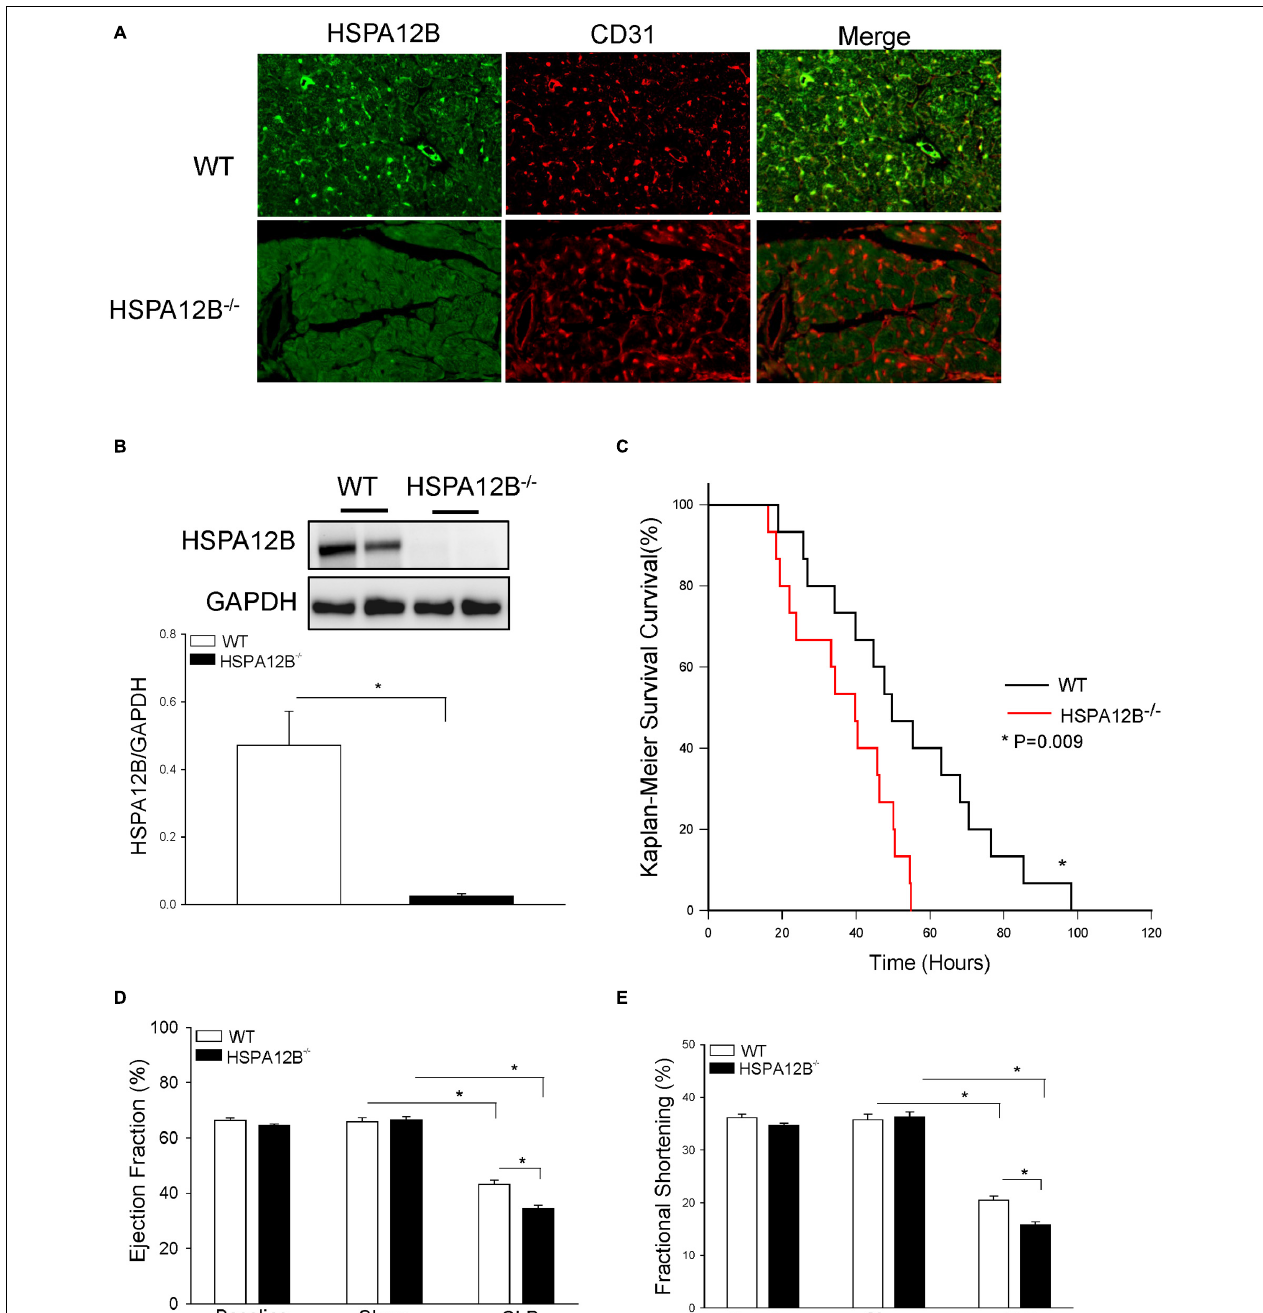
FIGURE 1 | Endothelial-specific deficiency of HSPA12B results in increased mortality and worsened cardiac dysfunction in polymicrobial sepsis. (A,B) HSPA12B is expressed in the ECs of WT myocardium but not in HSPA12B − / − mice. (A) Heart tissues from WT and HSPA12B − / − mice were sectioned and subjected to immunostaining with anti-CD31 (EC marker) and anti-HSPA12B. There is a negative staining of HSPA12B in the myocardium of HSPA12B − / − mice. The immunofluorescent staining was examined with fluorescent microscope (40 × ). (B) Western blot analysis of HSPA12B expression in the myocardium of WT and HSPA12B − / − mice. (C) Sepsis increases the mortality of HSPA12B − / − mice. Wild-type and HSPA12B − / − mice were subjected to CLP sepsis. Sham surgical operation served as sham control. The survival rate was closely monitored up to 5 days ( n = 15–16/group). (D,E) Cardiac function was examined by echocardiography before and 6 h after CLP ( n = 6–13/group). Cecal ligation and puncture sepsis markedly decreases ejection fraction (EF %) and fractional shortening (FS %) in WT mice. However, the values of EF % and FS % in HSPA12B − / − septic mice were further decreased compared with WT septic mice. (D) (EF %) and (E) (FS %). * P < 0.05 compared with indicated group.